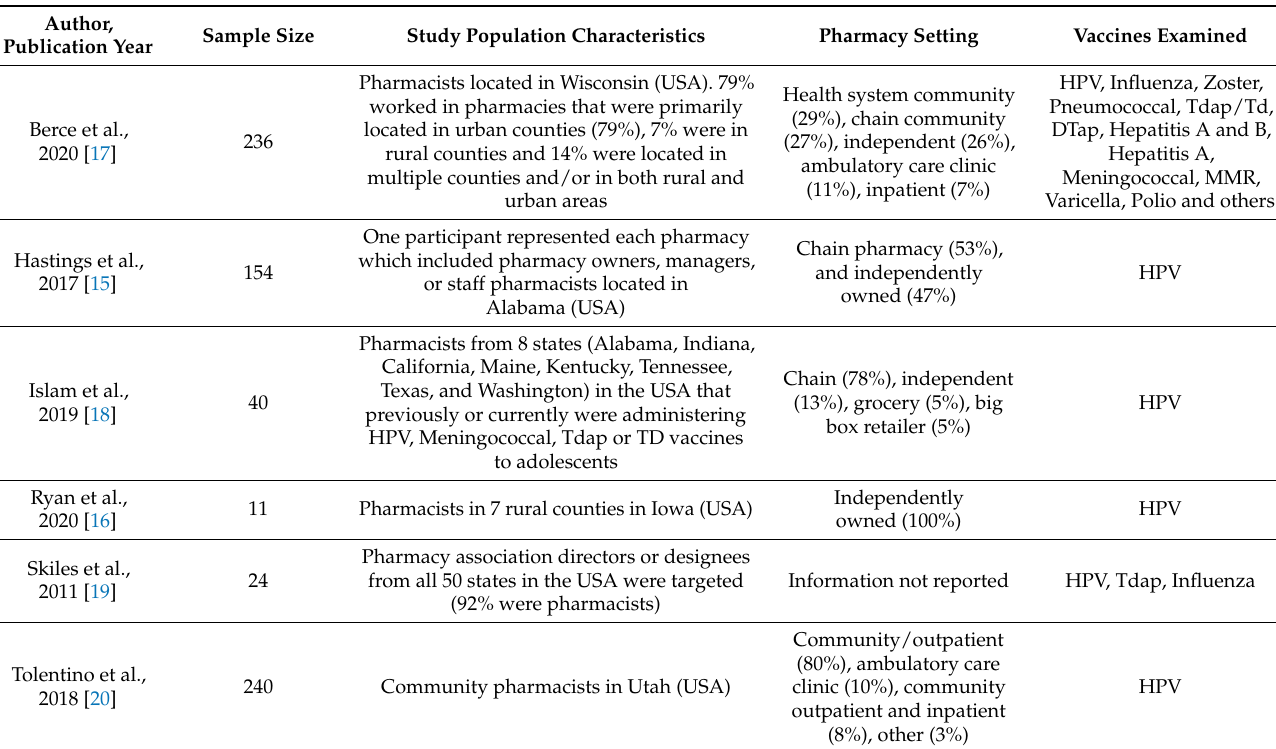
Table 1. Characteristics of included studies.